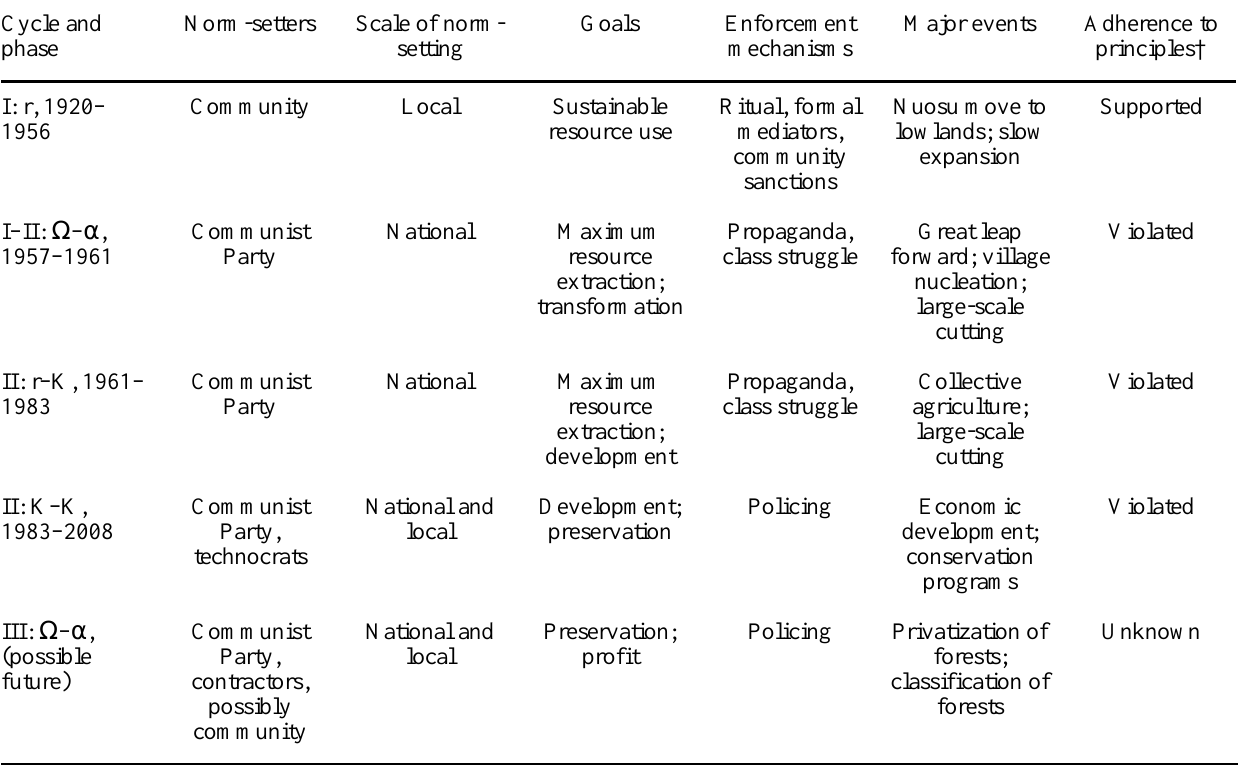
Table 3. Timeline of ecological and political change in the Upper Baiwu watershed, 1920–2008. Historical dates are aligned with phases in the adaptive